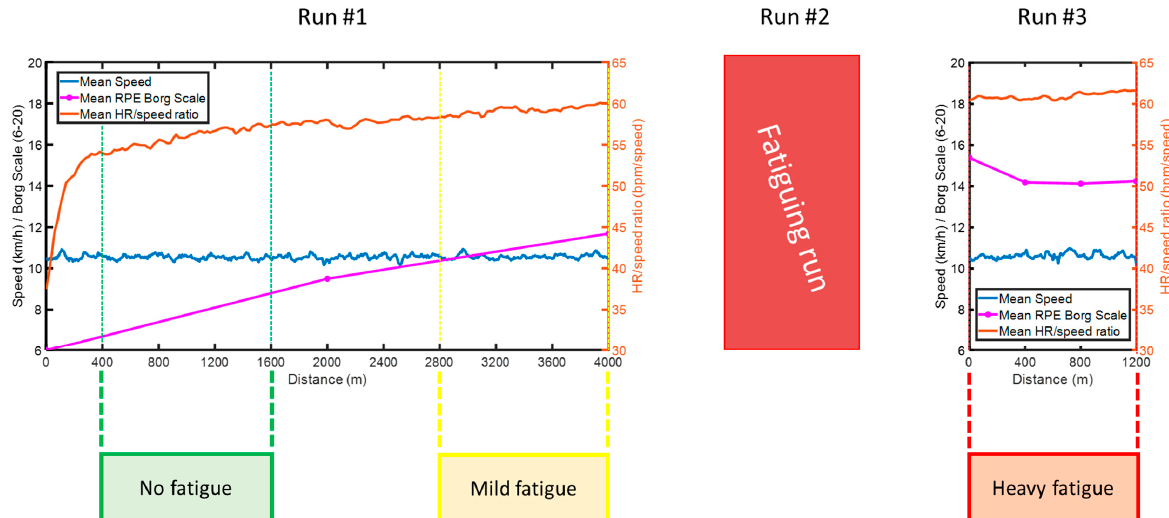
Figure 3. Mean speed (km/h), RPE Borg Scale (6–20) and HR/speed ratio (bpm/speed) for the runs performed in this study. The first run lasted 4000 m and was performed at a speed level controlled by a cyclist; the second (fatiguing) run was performed at increasingly higher speed and lasted between 400 m and 1200 m, until a RPE of 16 or higher was reached; the third run lasted 1200 m and was performed at a speed level controlled by a cyclist and equal to the first run. The three identified fatigue conditions are highlighted in green (400–1600 m), yellow (2800–4000 m) and red (0–1200 m post fatiguing run).